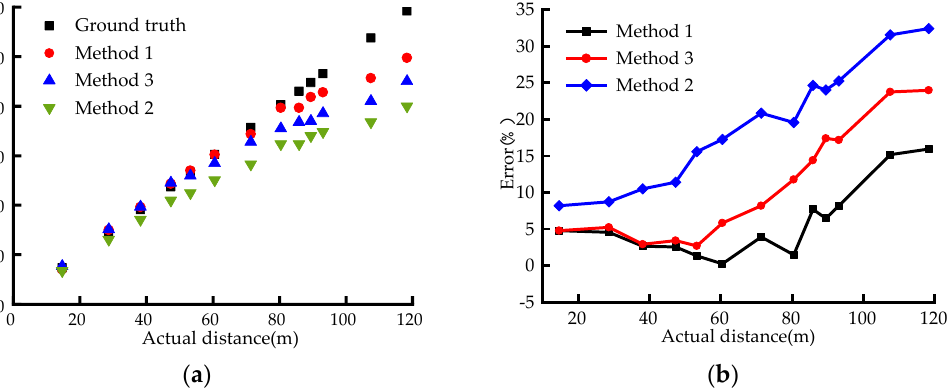
Figure 10. Analysis of the ranging results. ( a ) Comparison of ranging results; ( b ) Comparison of ranging errors.